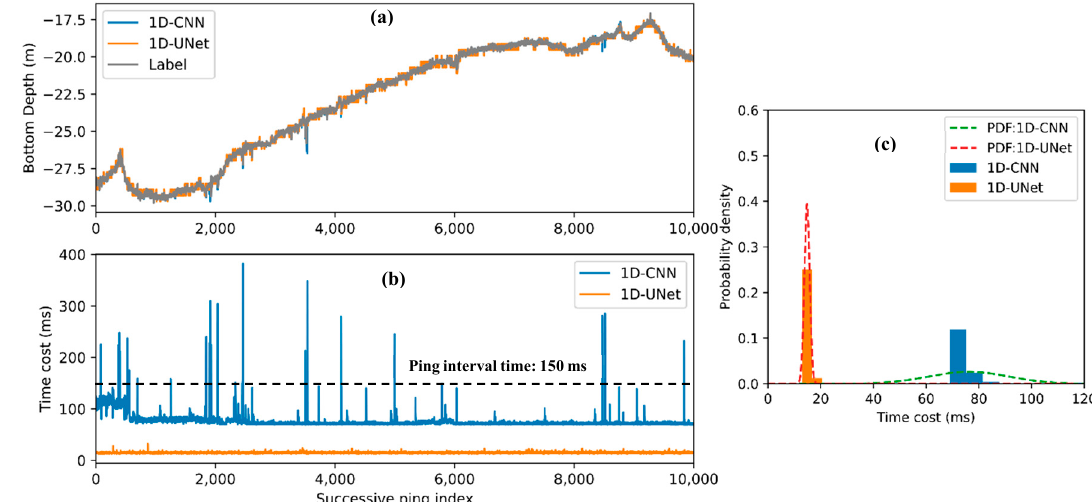
Figure 13. Real-time experimental results of 10,000 successive pings using 1D-CNN and 1D-UNet. These results were processed by the computer with AMD R5-2600X CPU and GTX-2070 GPU. ( a ) shows the bottom detection results of these pings; ( b ) shows the corresponding time costs of each ping using 1D-CNN and 1D-UNet; ( c ) shows the histogram and PDF curves of the time costs of 1D-CNN and 1D-UNet.